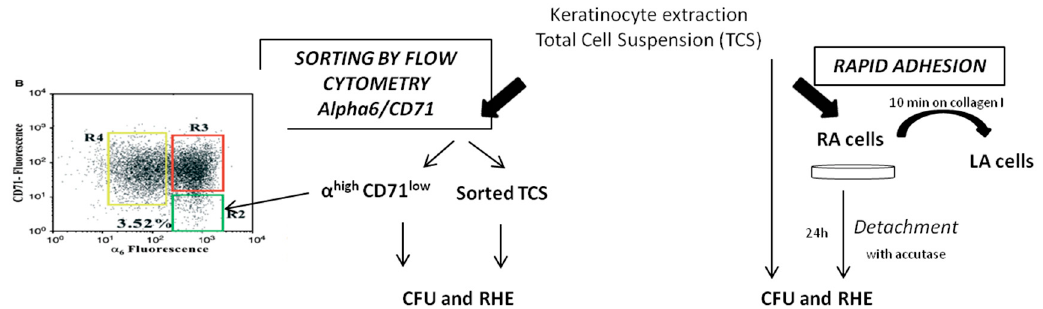
Figure 6. Experimental protocol of the comparison of the functional characterization of RA and the α high CD71 low population. Arrows correspond to following steps.